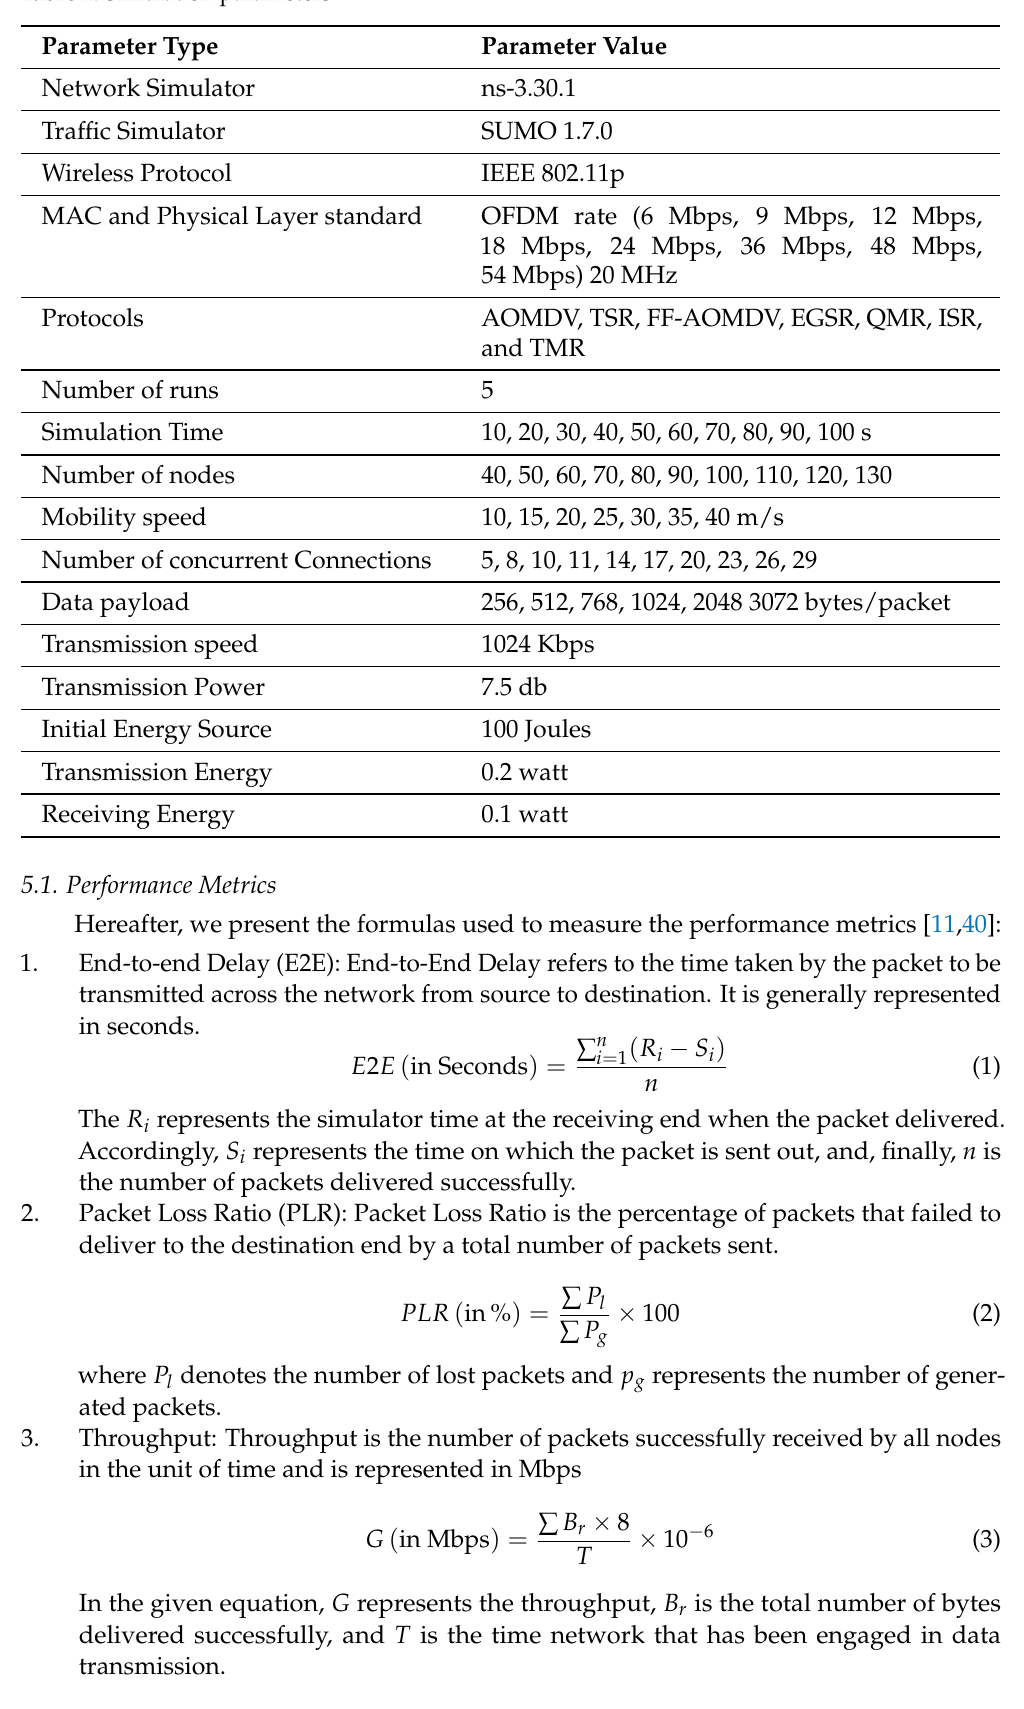
Table 1. Simulation